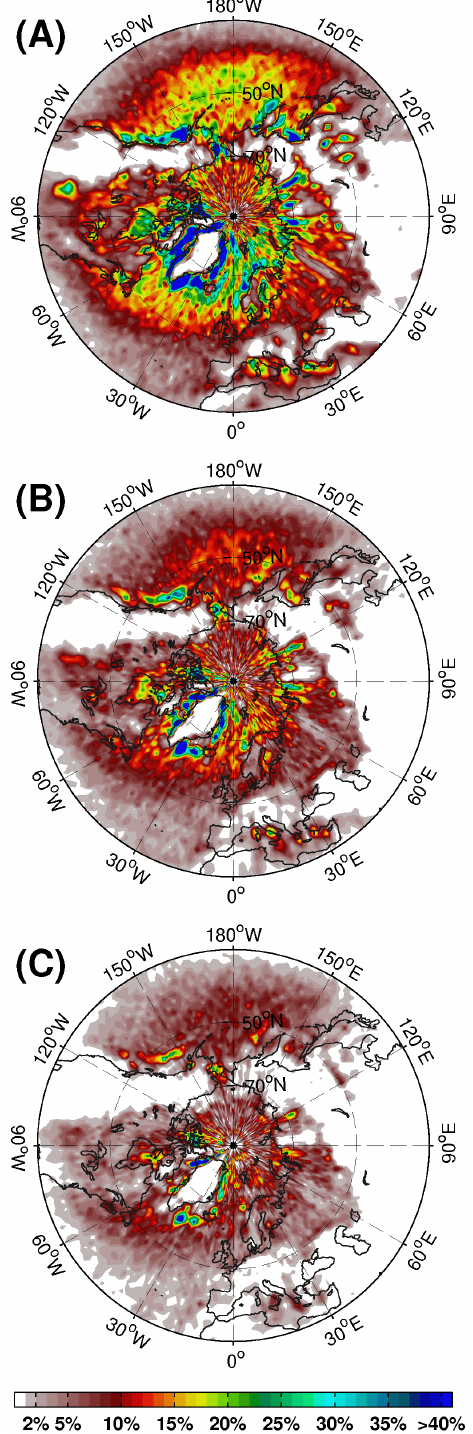
Figure 8. Cyclone center density expressed as the percentage of cyclone occurrence per time step and per unit area of 1000km 2 for (a) filter3, (b) filter5 and (c) filter7.